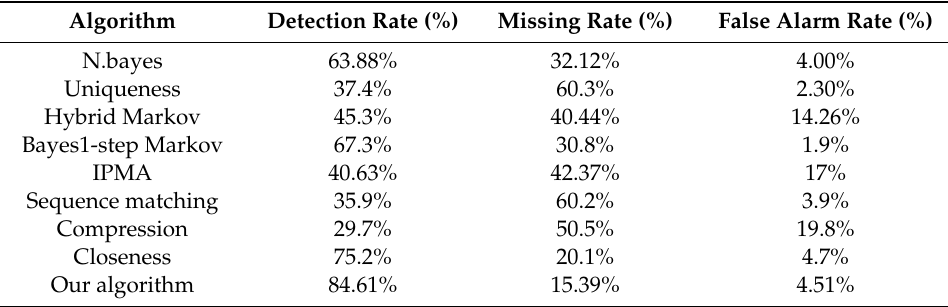
Table 6. Comparison between di ff erent algorithms on UNM_